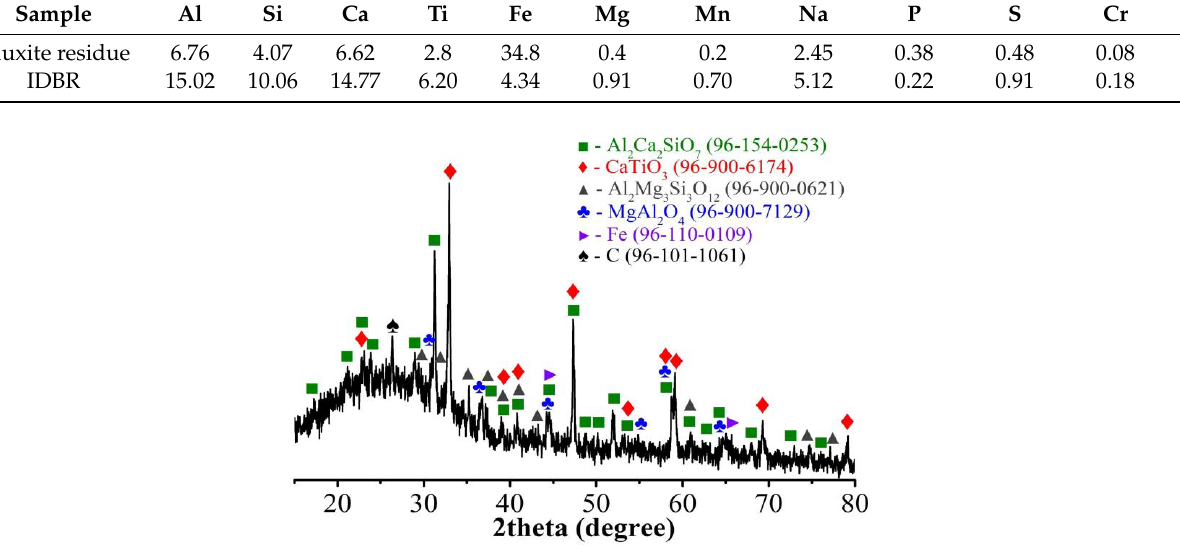
Figure 2. XRD pattern of the IDBR sample.